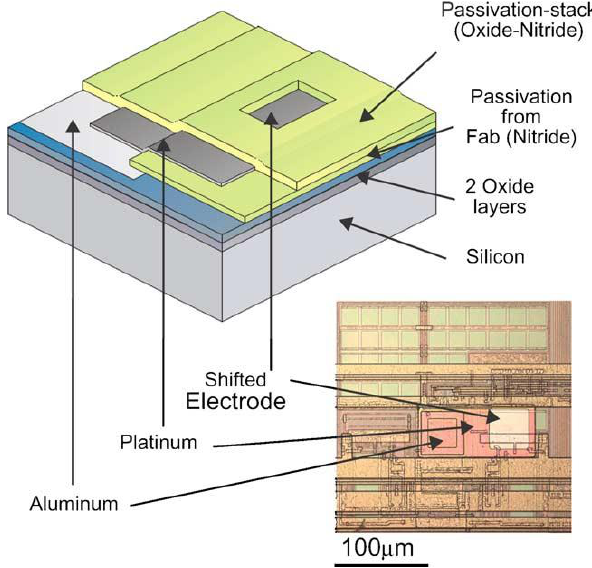
Figure 6. Adaptation of CMOS using photolithographic processing to re-define